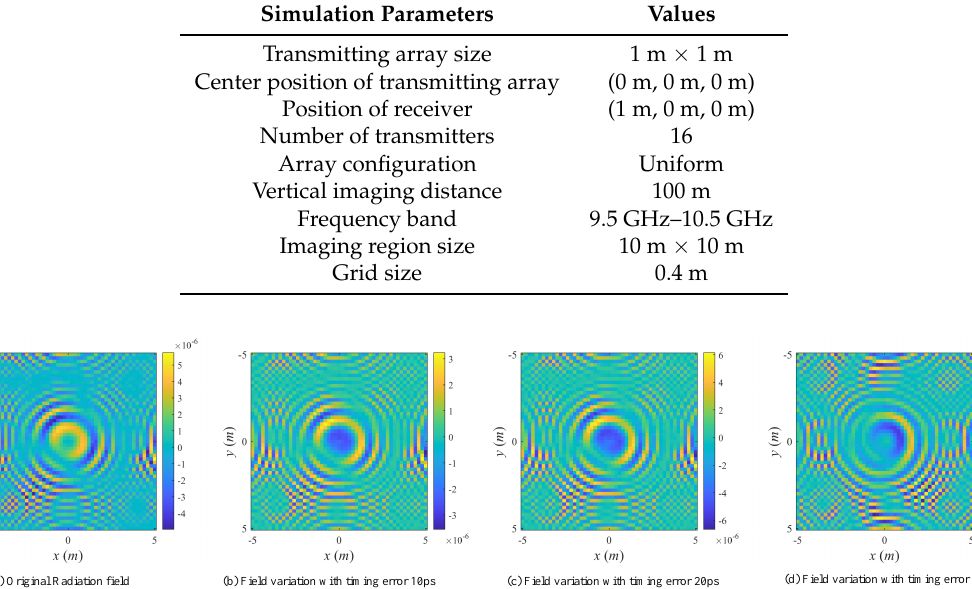
Figure 5. Original radiation field and field variations versus different types of imaging errors.